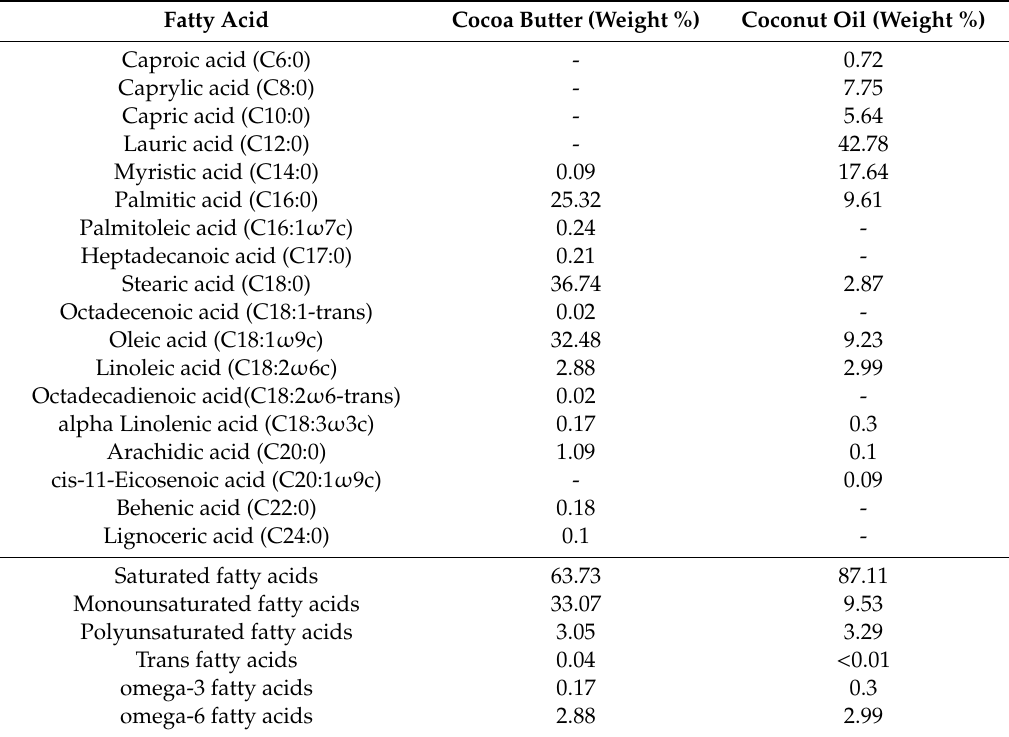
Table 1. Fatty acid composition of cocoa butter (CB) and coconut oil (CO).